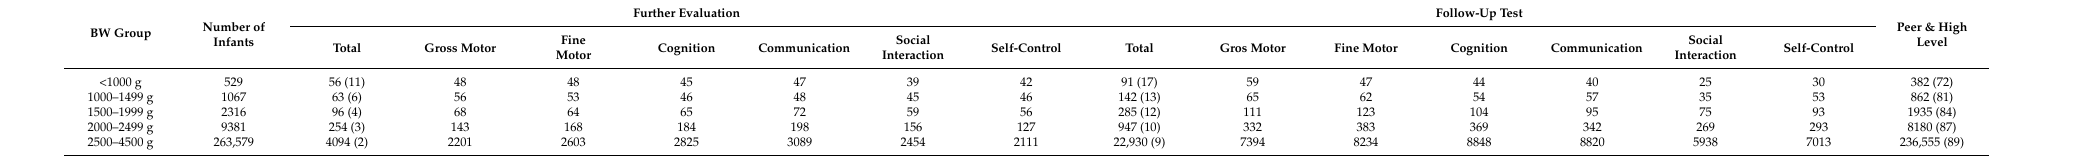
Data are presented as Number or Number (%). BW, birth